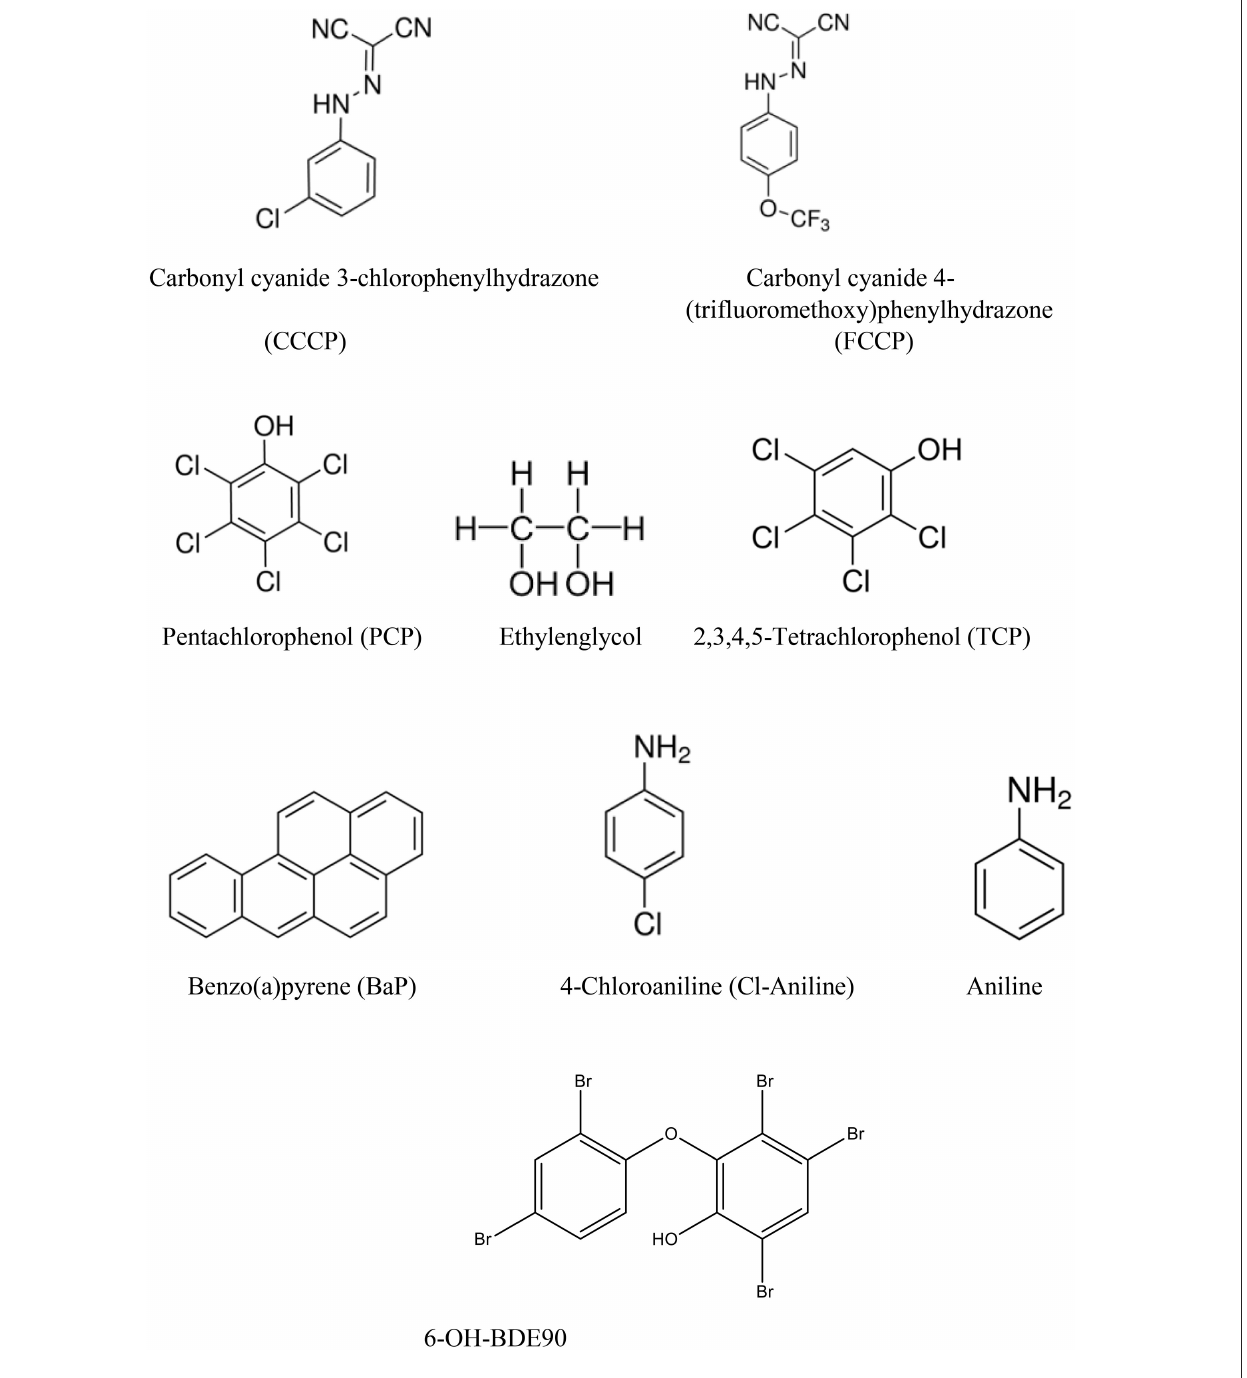
FIGURE 1 | Chemical structures of all the compounds studied.